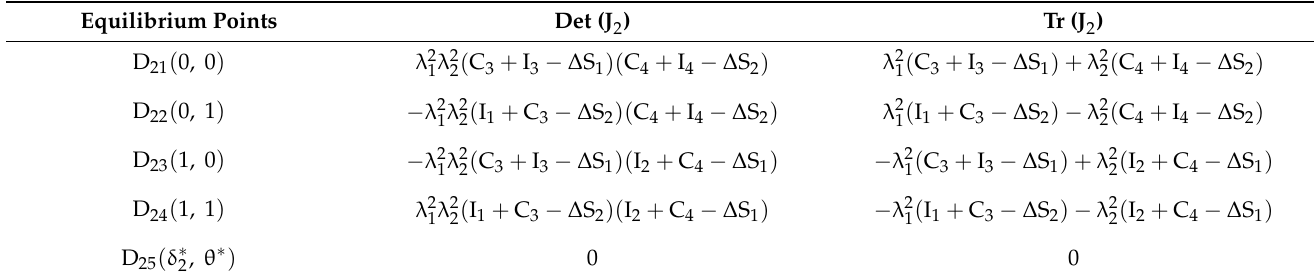
Table 4. Determinants and traces of equilibrium points under nonlitigation settlement. Equilibrium Points Det (J 2